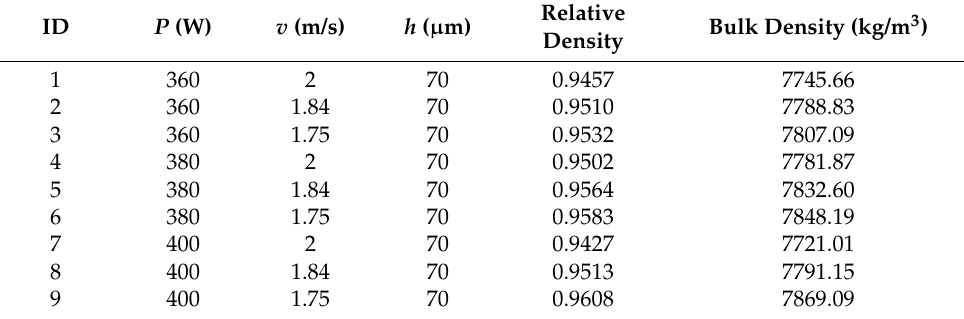
Table A1. Manufacturing parameters and experimental data adapted from [13]. Complement- ing relevant information and assumptions are the following; material: In718, theoretical